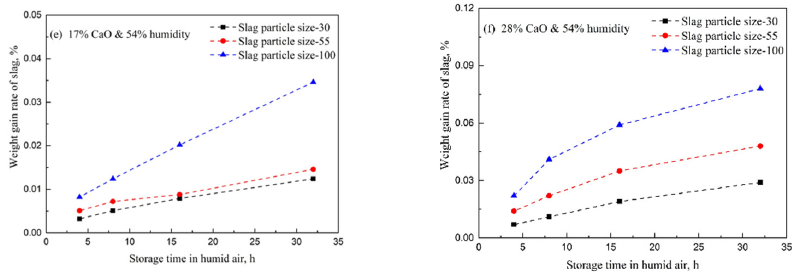
Figure 4. Experimental results of heated SWGR in the humid air.